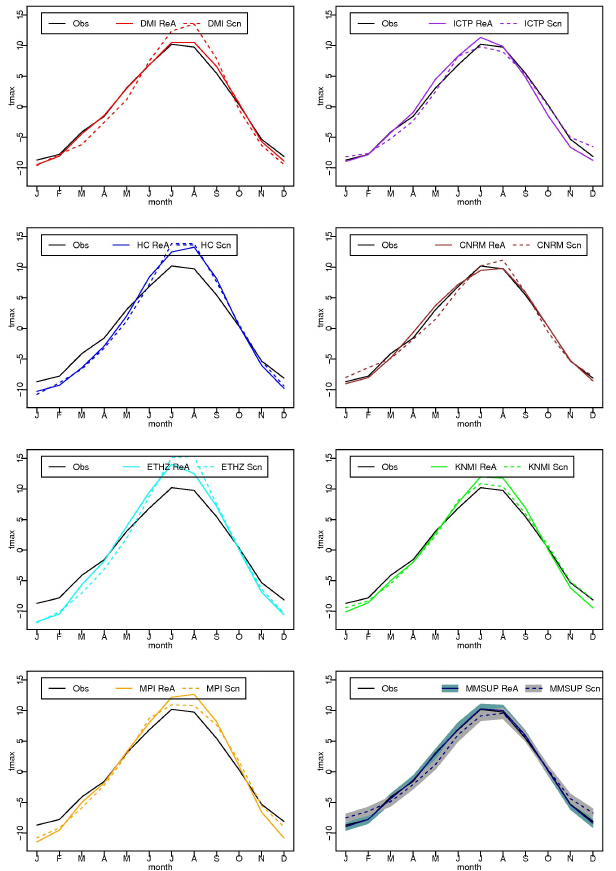
Fig. 6. Comparison between seasonal component from observations obtained with optimal interpolation of Piemonte data (black lines), reanalysis runs (solid lines) and scenario runs (dashed lines) for different models (acronyms in Table 1) and multimodel superensemble (MMSUP) in the period 1981–2000. Multimodel training period: 1961–1980. Multimodel uncertainty (square root of the total multi-Normal variance) is represented as confidence bands.